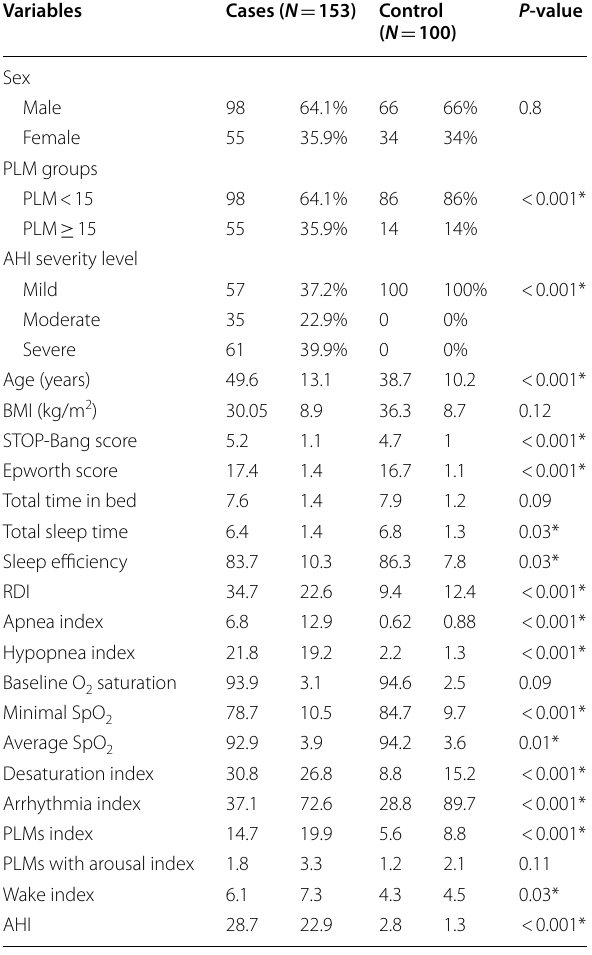
Table 1 Comparisons of study parameters in different study